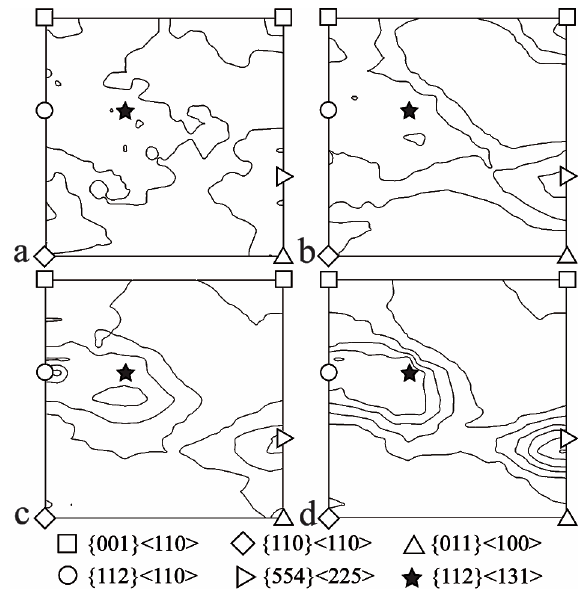
Figure 10. φ 2 = 45° sections of ODFs for specimen ( a ) 0Mo, ( b ) 0.25Mo, ( c ) 0.5Mo, ( d ) 0.25Mo–Nb. (Levels: 0.5,1.0,1.5,2.0…).